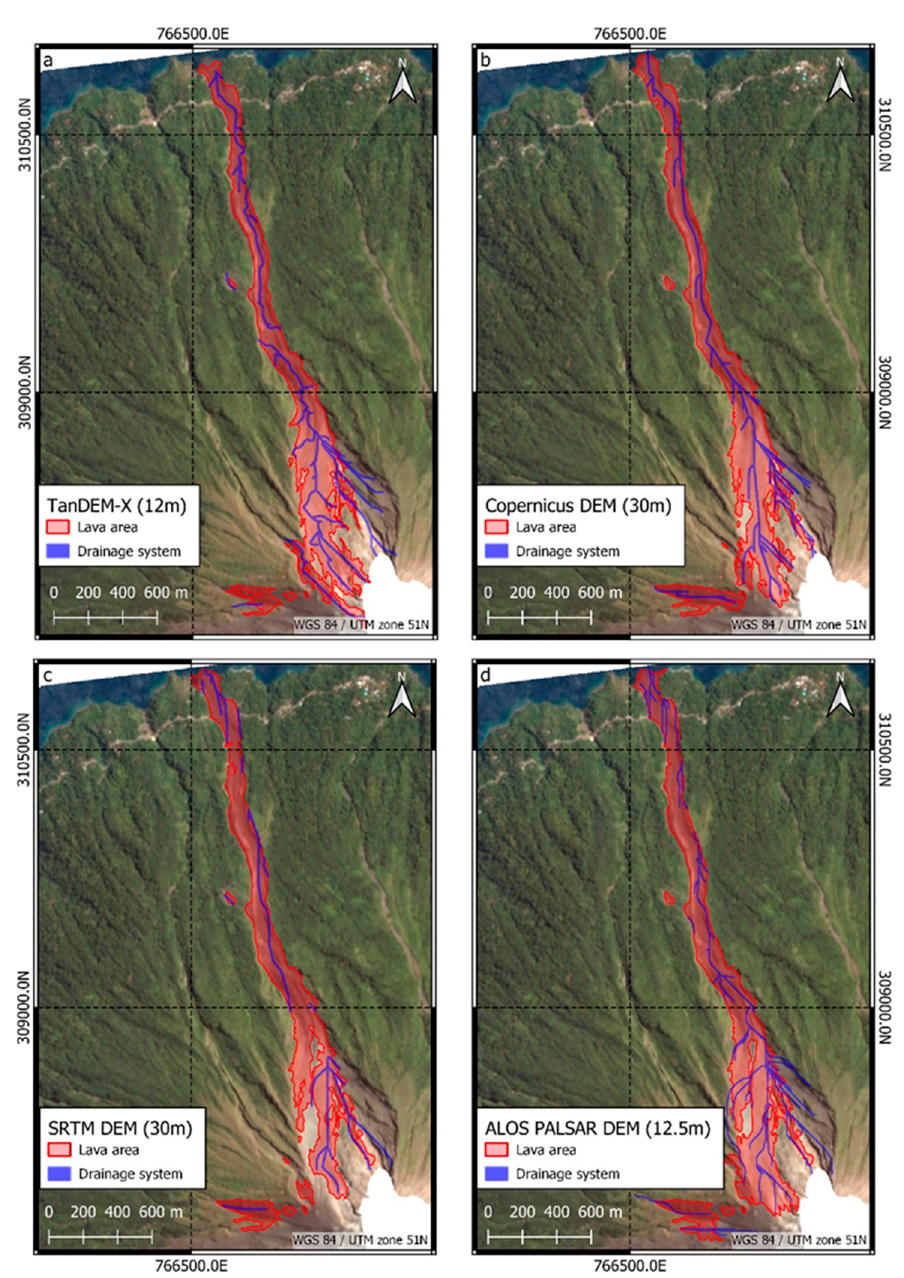
Figure 10. Results of the OBIA method with different drainage system models from TanDEM-X ( a ), Copernicus ( b ), SRTM ( c ), and ALOS PALSAR ( d ) DEMs for the Karangetang I eruptive phase. A threshold value for the extraction of the main outflows was set manually according to the resolution of the DEMs. The TanDEM-X discharge model most accurately derives the lava flow area in the unvegetated area. In the E of the unvegetated area, misclassifications are found in all results. Addi- tionally, noticeable are the partially interrupted outflows in TanDEM-X, SRTM, and ALOS PALSAR DEMs, which are probably due to data errors.